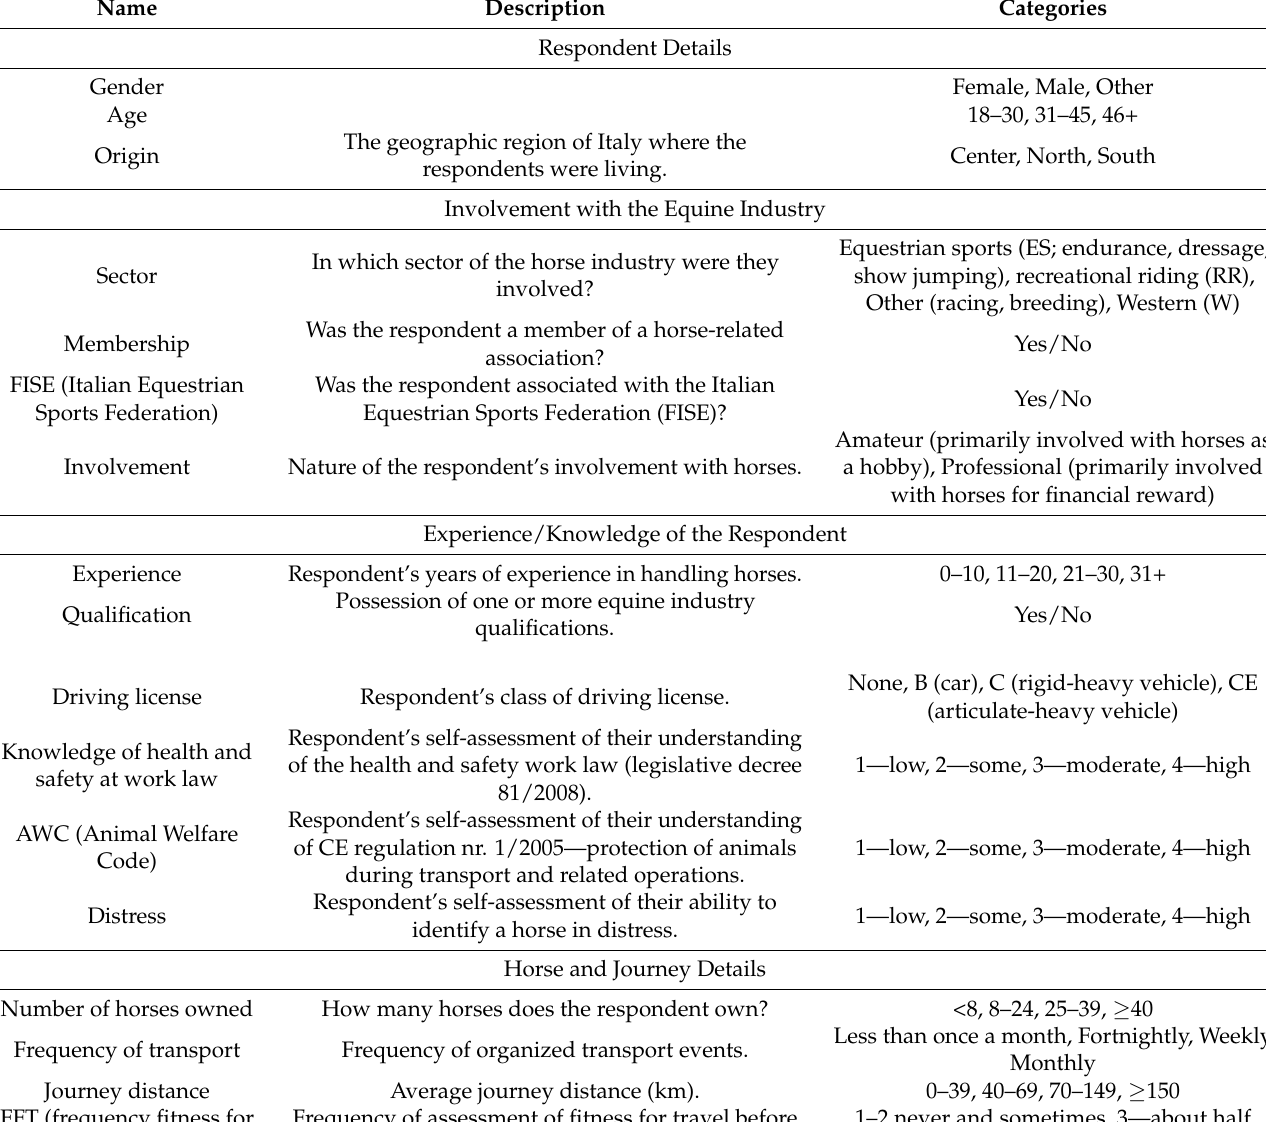
Table 2. Name and description of the candidate explanatory variables evaluated in a survey on horse road transport practices, transport-related problem behaviors, horse injuries, and horse handler injuries in